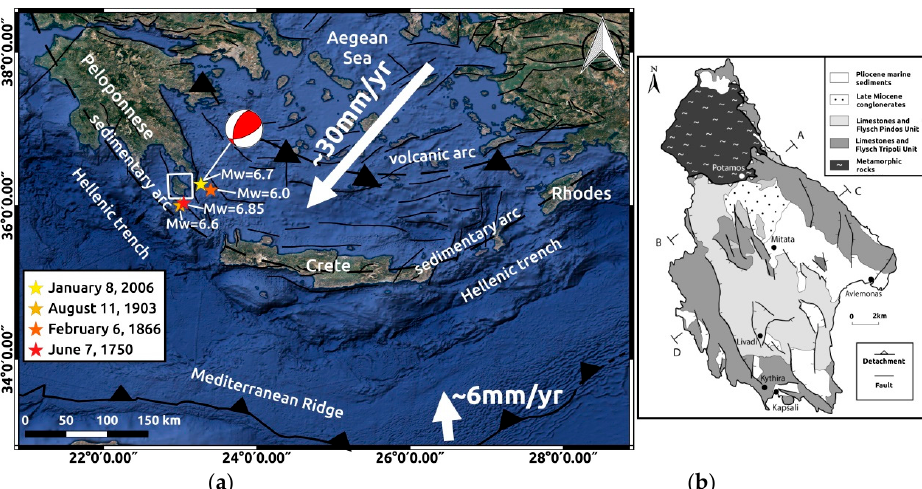
Figure 1. ( a ) The most significant tectonic features of the Hellenic Subduction Zone (HSZ). Arrows show the relative motion of the Nubian lithosphere and the Eurasian lithospheric plate at the Aegean Sea area [1]. Fault sources are obtained by the European Database of Seismogenic Faults [19]. Stars illustrate epicenters of important historical earthquakes in the Kythira strait: 1750, 1866, 1903 after [17], 2006 after [20]. Beach-ball shows the 2006 earthquake fault-plane solution [21]; ( b ) Tectonic map of Kythira Island (adapted from: [22]).